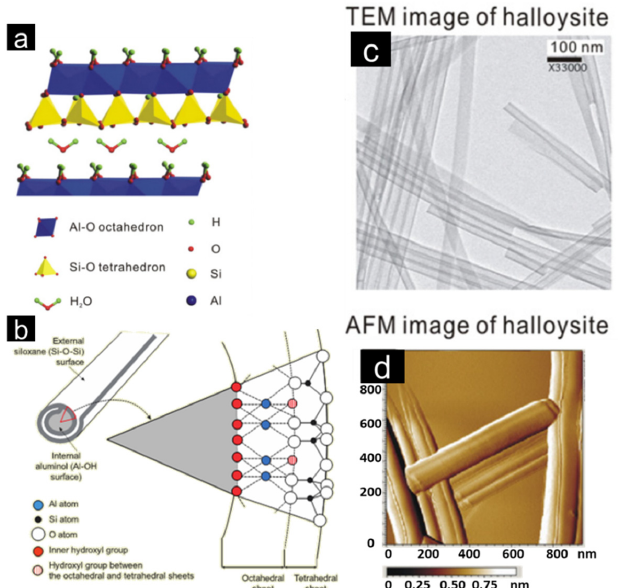
Figure 2. ( a , b ) HNTs crystal morphology and atomic structure; ( c , d ) TEM and AFM images of HNTs. Adapted with permission from ref.